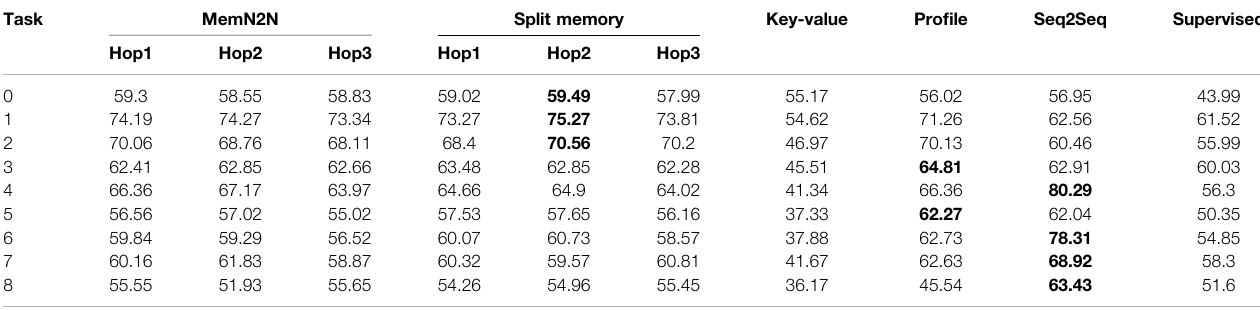
TABLE 7 | The test set results of the Personalised Barista Dataset with Second Interaction set (few-shot learning). The best performing methods (or methods within 0.1% of best performing) are given in bold for the per-response accuracy metric. The results show that on average and for task 8 (containing all tasks), Seq2Seq is the best performing model.